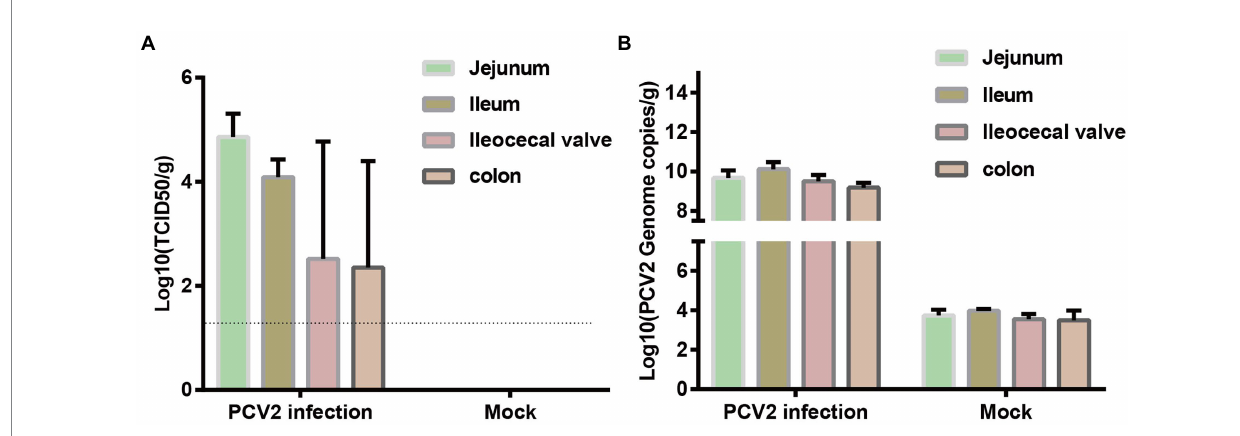
FIGURE 1 Distribution of PCV2 in different segments of porcine intestinal tissues. Three piglets in each group were infected with PCV2d-LNHC or medium (negative control). Samples from different intestinal segments from the six piglets were collected to detect the distribution of PCV2 at 28 dpi. (A) Virus titration was used to determine the titer of PCV2 in the intestinal tissues. The dotted line shows the detection limit, and the value under the dotted line is considered to be ‘undetected’. (B) Number of PCV2 genomes determined with